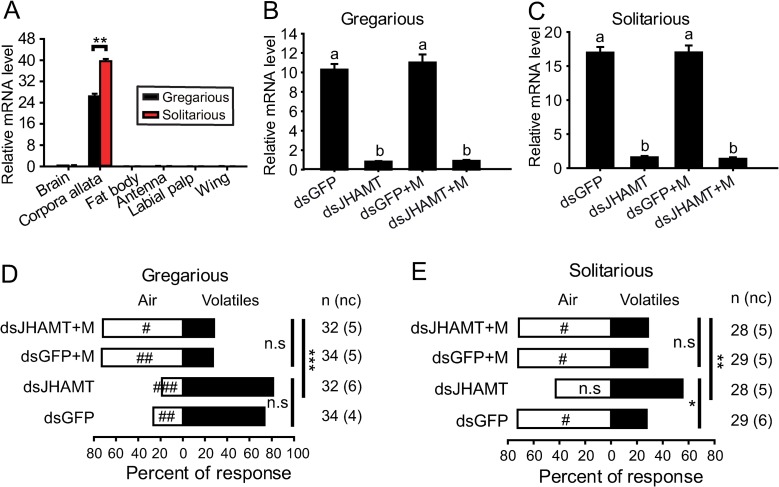
Effect of JHAMT knockdown on choice behavior in the fourth-instar nymphs.(A) Relative mRNA level of JHAMT in six selected tissues of gregarious and solitarious nymphs, respectively. (B) Relative mRNA level of JHAMT after injection of dsGFP or dsJHAMT or rescued by methoprene in gregarious nymphs. (C) Relative mRNA level of JHAMT after injection of dsGFP or dsJHAMT or rescued by methoprene in solitarious nymphs. (D) Choice behavior of gregarious nymphs at Day 3 after injection of dsGFP or dsJHAMT or rescued by methoprene in gregarious nymphs. (E) Choice behavior of gregarious nymphs at Day 3 after injection of dsGFP or dsJHAMT or rescued by methoprene in solitarious nymphs.